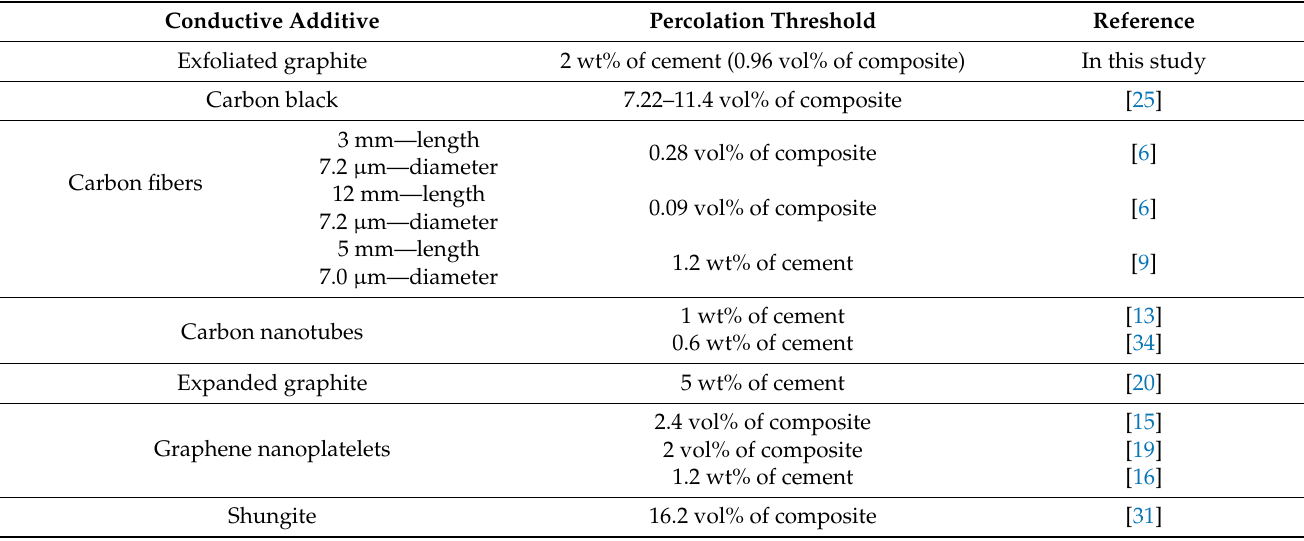
Table 2. Percolation thresholds for cement composites with different conductive